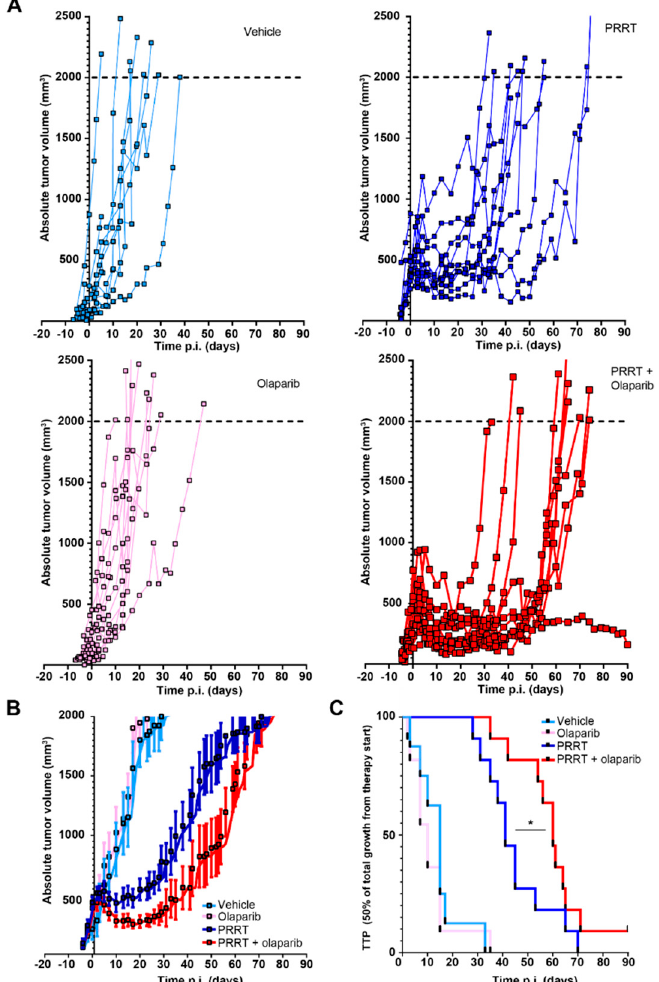
Figure 2. Combination of PRRT and olaparib synergistically enhances tumor control in vivo in mice bearing CA20948 tumors. ( A ) CA20948 tumor growth curve showing absolute tumor volumes of mice that were treated with vehicle, olaparib, PRRT or the combination of PRRT and olaparib. ( B ) Combination of all absolute tumor volumes per treatment group. Error bars indicate Standard error of the mean. ( C ) TTP shown by Kaplan-Meijer curves of CA20948 tumor bearing mice that were treated with vehicle, olaparib, PRRT or the combination of PRRT and olaparib. * p < 0.05.